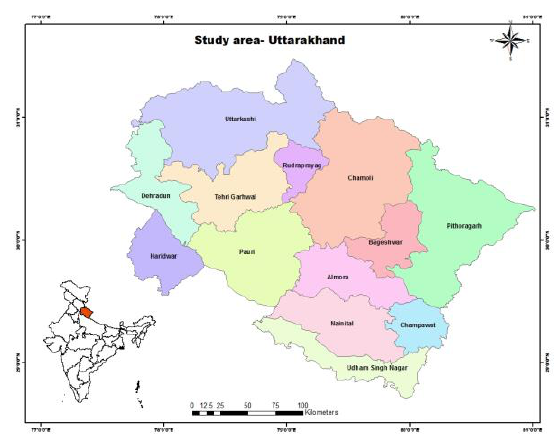
Figure 1. Study area map of Uttarakhand